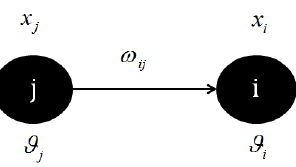
Figure 3. Connection between neurons i and j